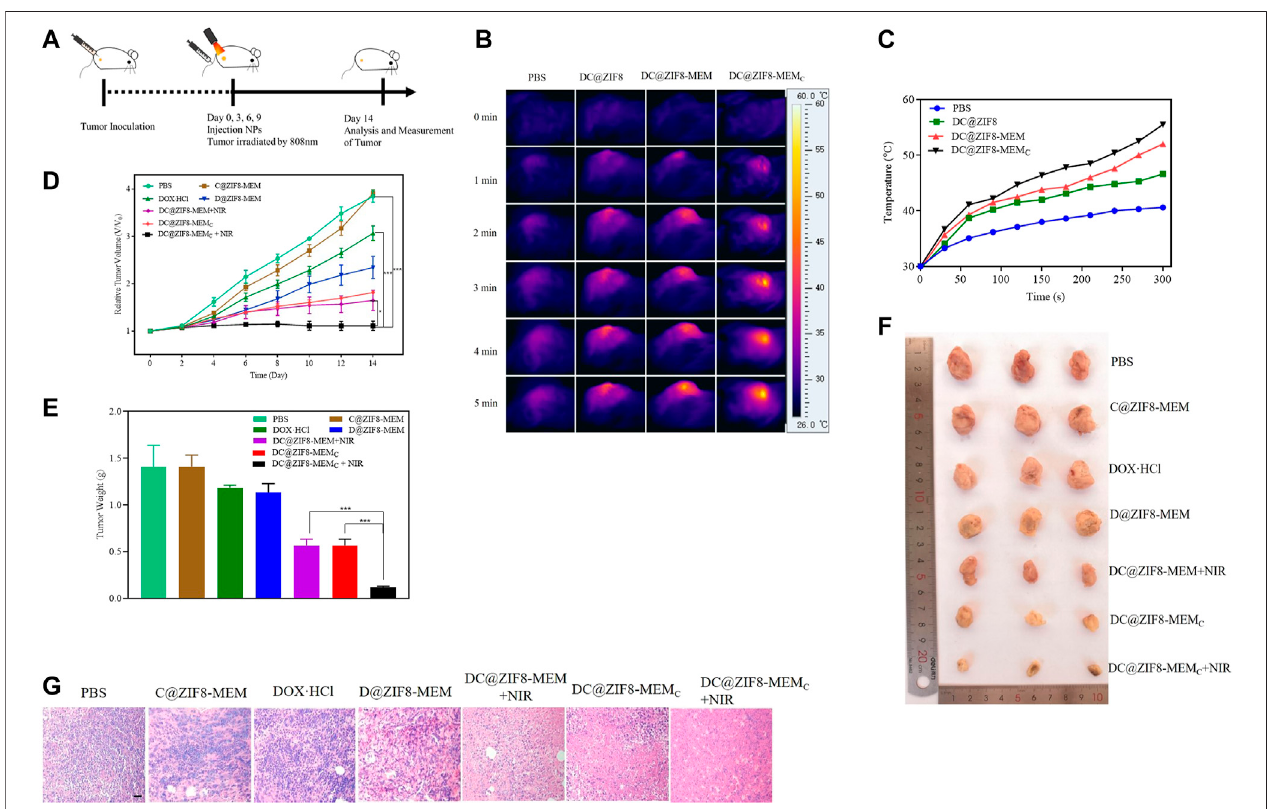
FIGURE 6 | Experimentation for the therapeutic model (A) . Photothermal images in vivo (B) . Temperature curves with 808 nm NIR at 2 W · cm − 2 for 5 min (C) . Relative tumor volumes of mice with different treatments (D) . Tumor weights of mice after different treatments (E) . Representative digital photographs of excised tumor tissues of mice with different treatments (F) . H&E-stained images of tumor tissues from mice after different treatments on the 14th day; scale bar = 20 µm (G) . All the above data on mice in each group were averagely calculated (n = 5). * p < 0.05, ** p < 0.01, *** p <